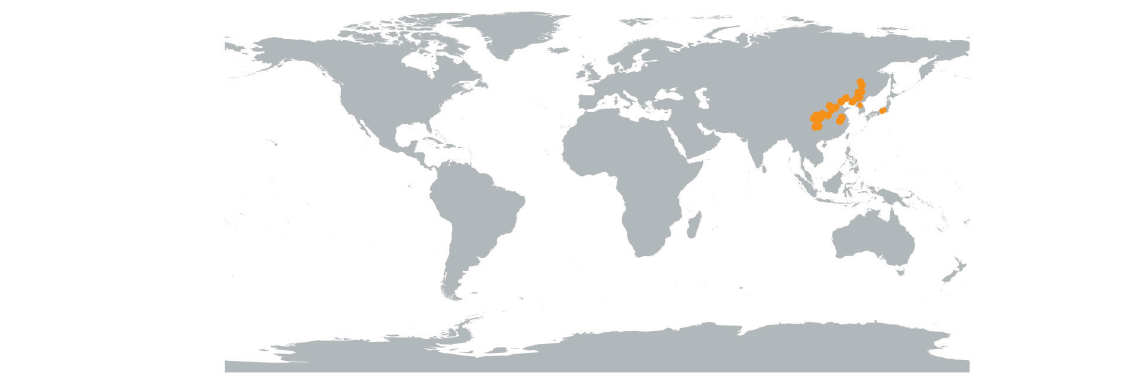
Fig. 9. Distribution of Malus baccata (L.) Borkh . var. mandshurica (Maxim.)